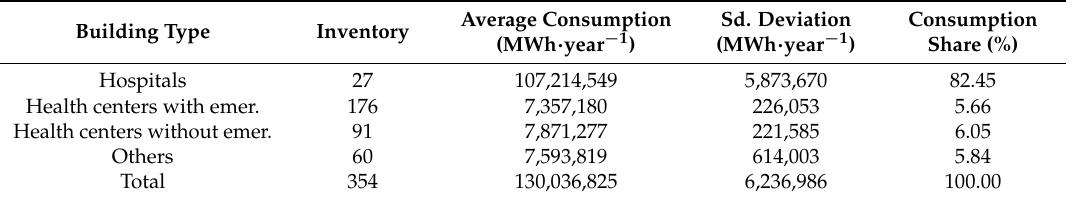
Table 1. Description of electrical energy consumption of the Public Health System (cid:48) s building stock in the Castilla y Le ó n region in Spain. Data source: Junta de Castilla y Le ó